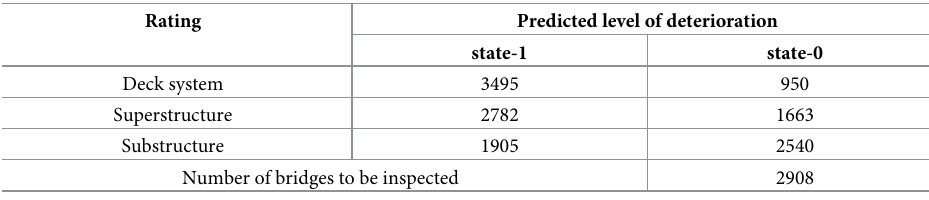
Table 9. The prediction results of DT model.